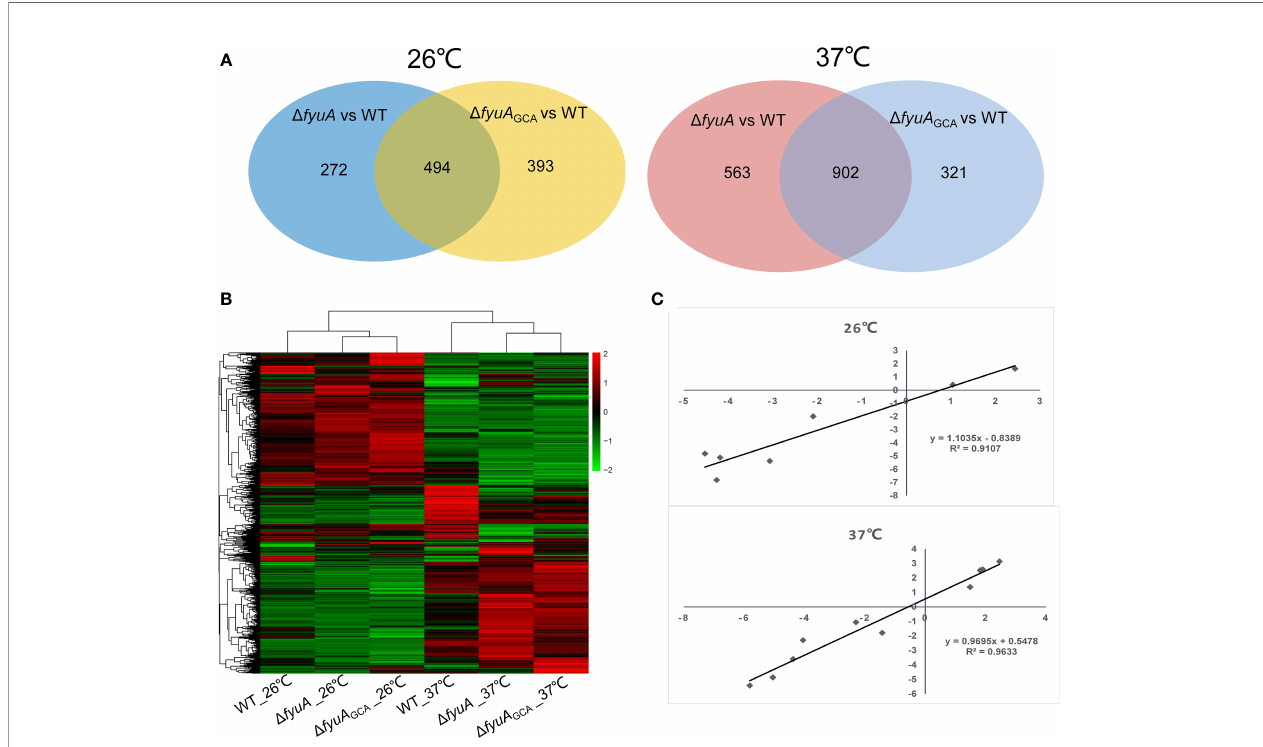
FIGURE 5 | Comparative transcriptomics of strain 201 and D fyuA GCAdel cultured at 26°C or 37°C. (A) Venn diagrams showing overlapping of the gene expression pro fi les between different comparison groups. (B) Clustering analysis of differential gene expression between WT and mutant strains. Different colors show different gene expression levels, with high expression being colored red and low expression being colored green. (C) Correlations among the expression levels of 17 genes measured with RNA-seq and qRT-PCR were analyzed using linear regression.